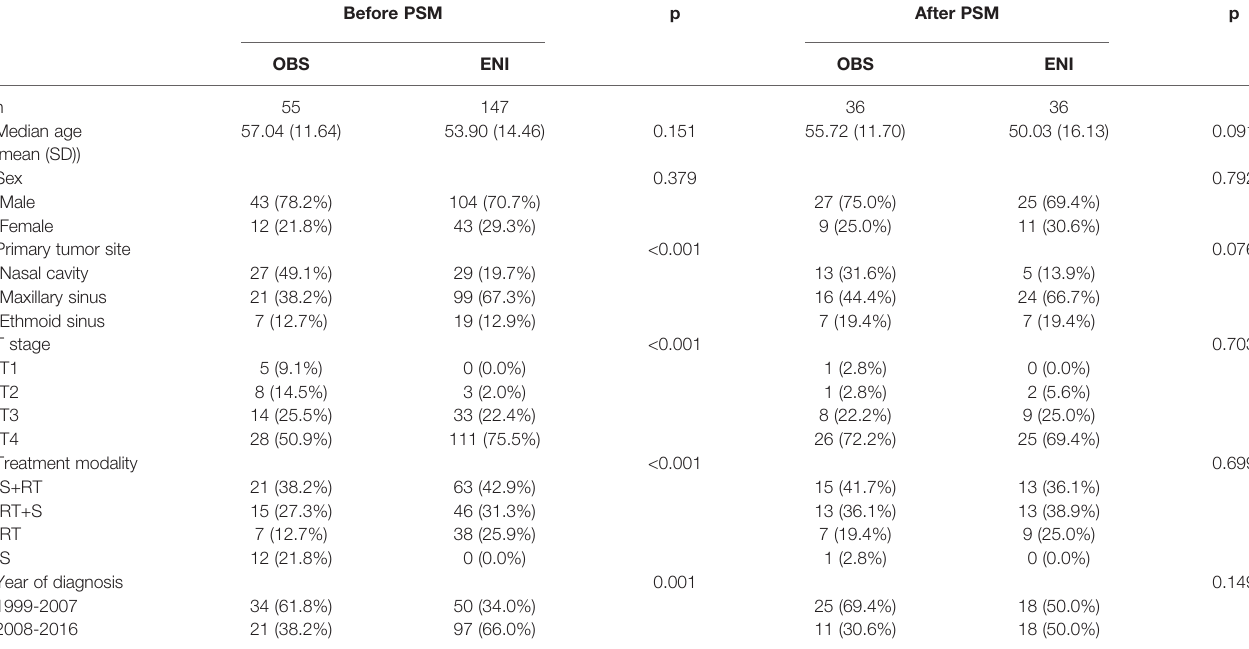
TABLE 2 | Characteristics of N0 patients undergoing observation (OBS) or elective neck irradiation (ENI) before and after PSM. Before